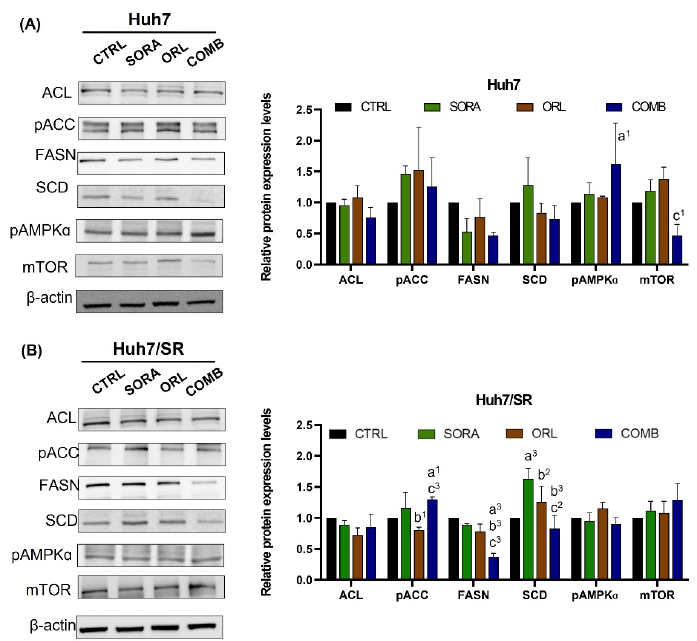
Figure 5. Combination treatment of sorafenib and orlistat changes the expressions of fatty acid synthesis-related and AMPK/mTOR-related proteins in ( A ) Huh7 and ( B ) Huh7/SR cells. Combination treatment caused reductions in FASN and SCD and increased pACC expression in both cell lines. Besides, the combination treatment activated the AMPK/mTOR pathway only in Huh7 cells but not in Huh7/SR cells. a, compared to Control; b, compared to Sorafenib; c, compared to Orlistat; 1 p < 0.05; 2 p < 0.01; 3 p < 0.001. As mentioned, sorafenib causes cell death mainly through ferroptosis instead of apoptosis. Figure 4 demonstrates that combination treatment increased the cleaved caspase-3 and Bax/Bcl-2 ratio more significantly in Huh7 cells than in Huh7/SR cells. Therefore, we investigated the changes in ferroptosis proteins resulting from treatments (Figure 6). Both sorafenib and orlistat suppressed xCT levels in both cell lines, and the suppression was less significant in Huh7/SR cells than in Huh7 cells. However, the reduc- tion in xCT in Huh7/SR cells was more profound than in Huh7 cells after receiving com- bination treatment. All treatments had a similar effect on GPX4 expression, but the effect on Huh7/SR cells was less evident than on Huh7 cells. Lastly, all treatments repressed KEAP1 expression significantly, as shown in Figure 6. Nevertheless, treatments resulted in different changes in NRF2 expressions in both cell lines. Prominent NRF2 elevation was found in all treatment groups in Huh7 cells, but the NRF2 increase was only detected in Huh7/SR cells after orlistat treatment.